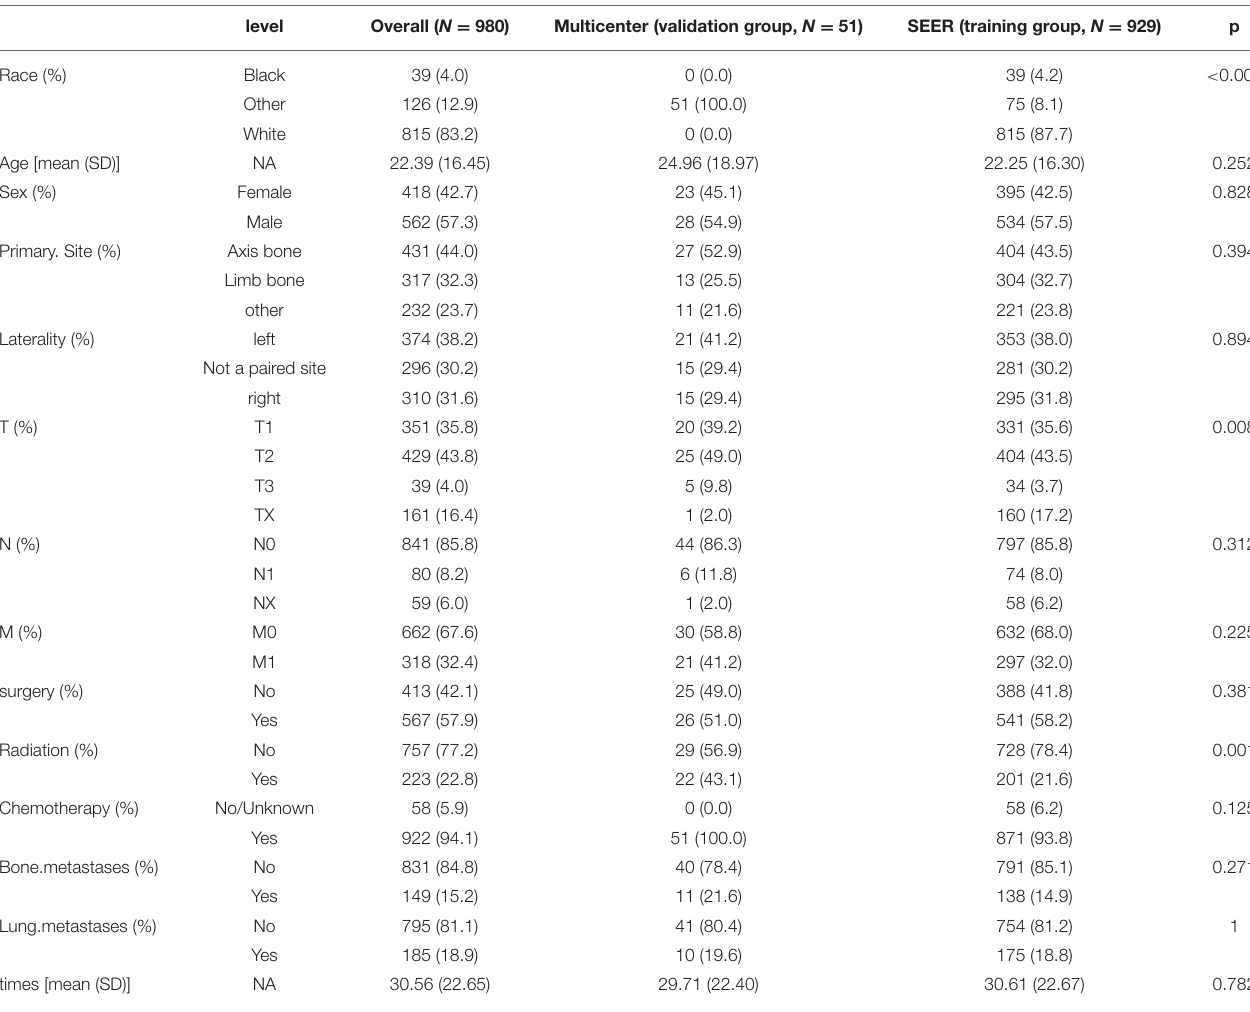
TABLE 1 | Baseline of patients with SEER database and multicenter